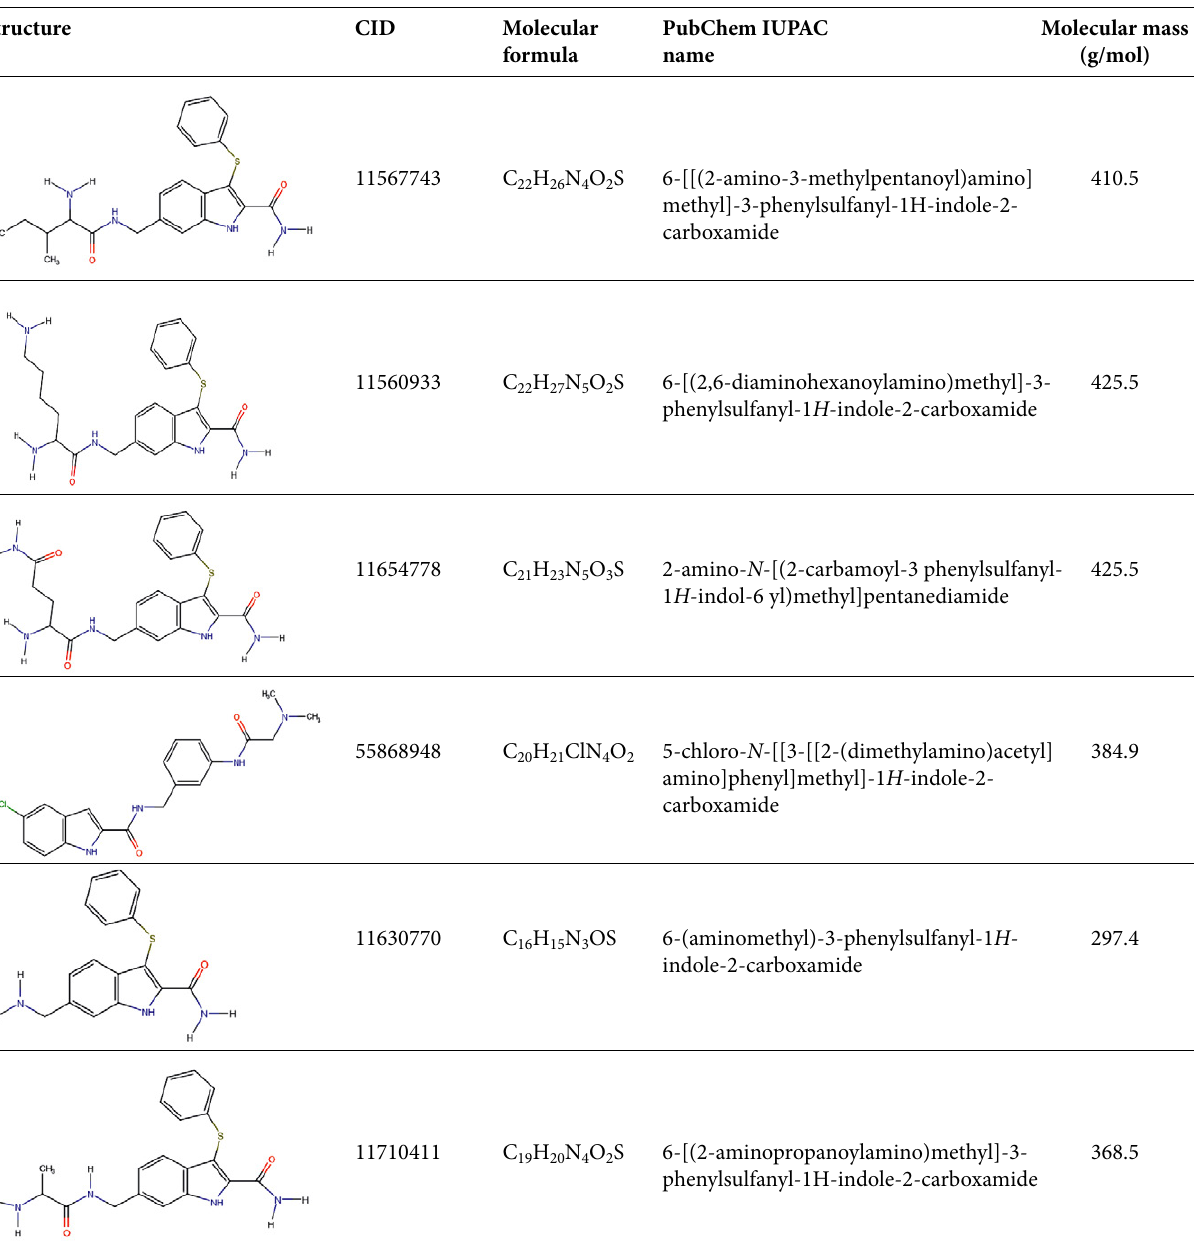
Table 5. Details of virtual screening compounds.